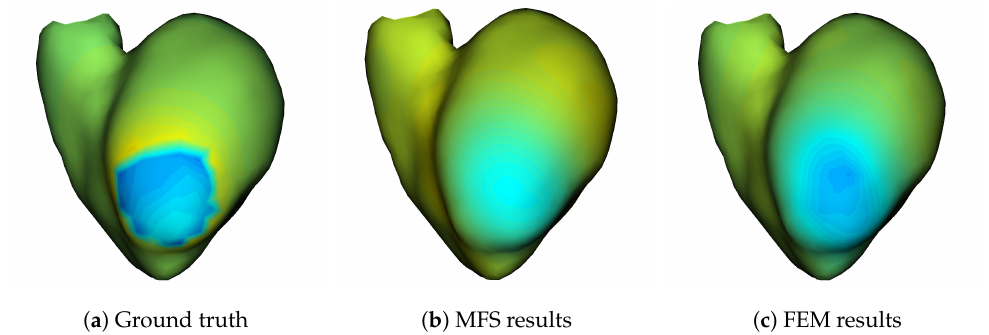
Figure 10. Distribution of the electrical potential on the heart surface. Simulated ground truth solution ( a ), MFS solution ( b ) and FEM solution ( c